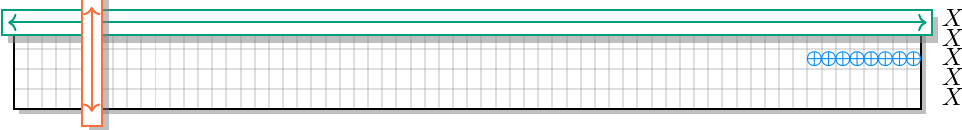
Figure 2: The column-wise S-box layer, the row-wise linear layer and the constant addition.